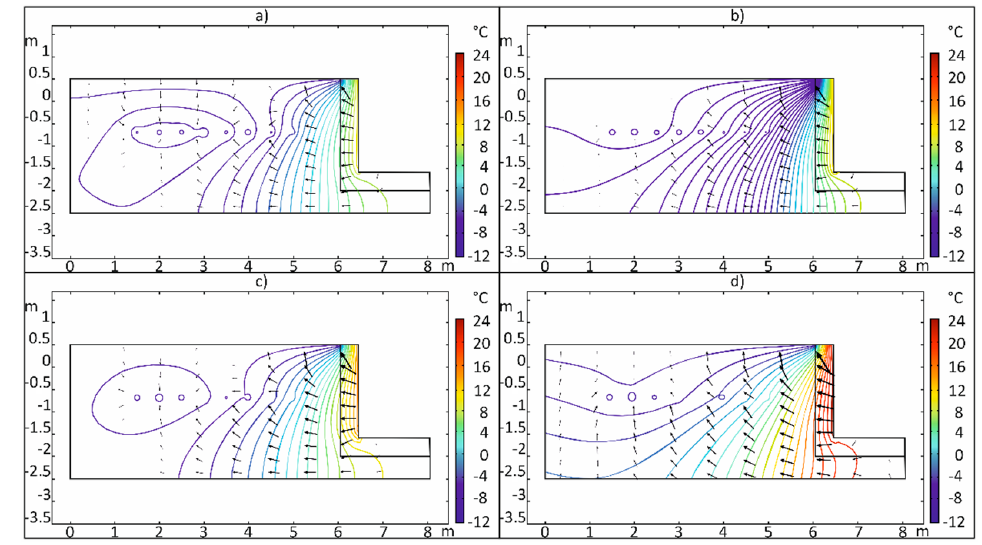
Figure 10. Bi-dimensional section through the HGHE, perpendicular to the basement wall for the day with the lowest temperature simulated, corresponding to the day of 27 January, as follows: ( a ) case 1–no auxiliary heat sources; ( b ) case 2–heated basement; ( c ) case 3–solar thermal panels; ( d ) case 4–both auxiliary heat sources. The arrows indicate the heat direction.